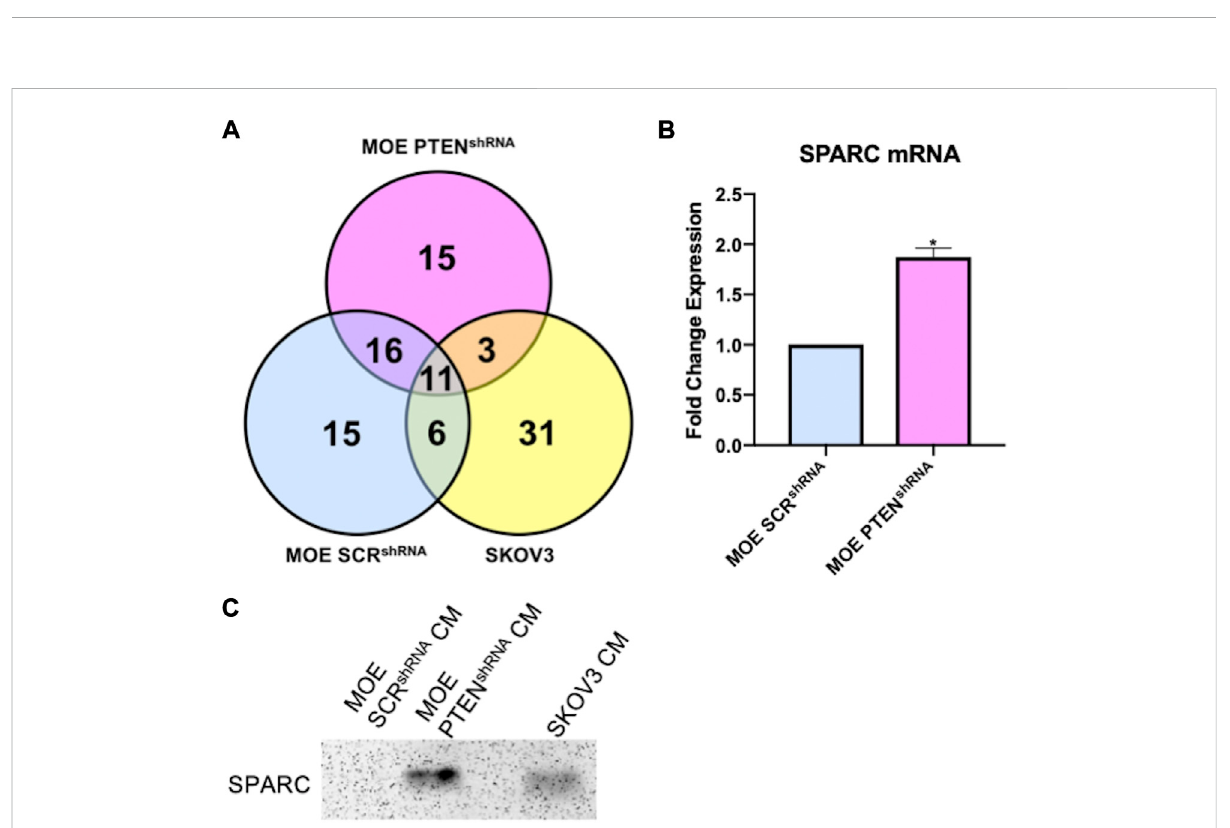
FIGURE 3 (A) Venn diagram ofproteins identi fi edfrom proteomics analysisinconditioned media 3 – 50 kDa samples from MOESCR shRNA , MOE PTEN shRNA , andSKOV3. (B) RNAsequencingdatademonstrateshighermRNAlevelsofSPARCinMOEPTEN shRNA cellsthaninMOESCR shRNA cells;unpaired t -test, * = p < 0.05. (C) Western blot shows higher expression of SPARC protein in MOE PTEN shRNA and SKOV3 conditioned media than in MOE SCR shRNA conditioned media. CM stands for conditioned